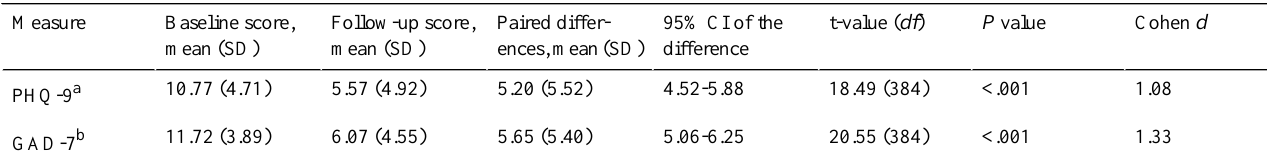
Table 5. Changes in depression and anxiety symptoms for participants starting at clinical levels of depression or anxiety symptoms (n=385).